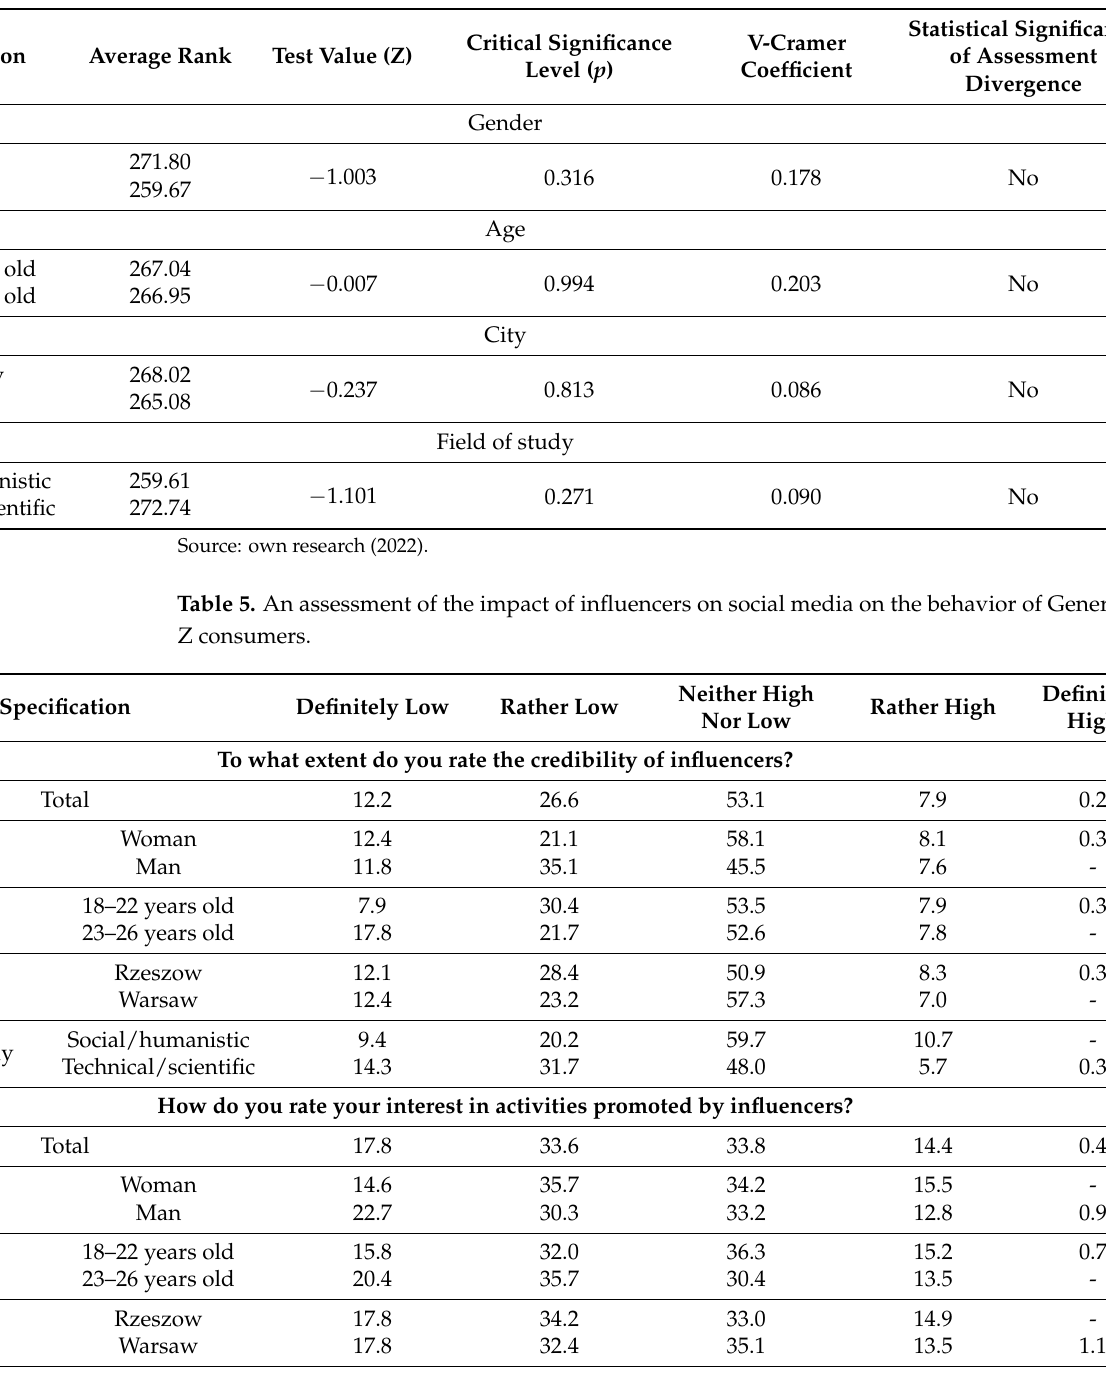
Table 4. An assessment of the relationship between the number of followed influencers and the variables describing the respondents.